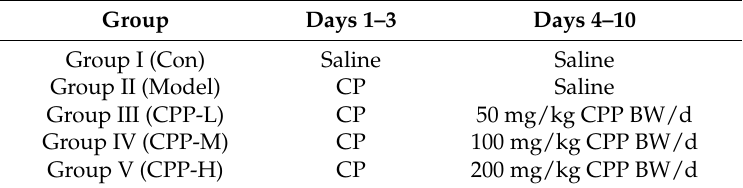
Table 3. The details of five